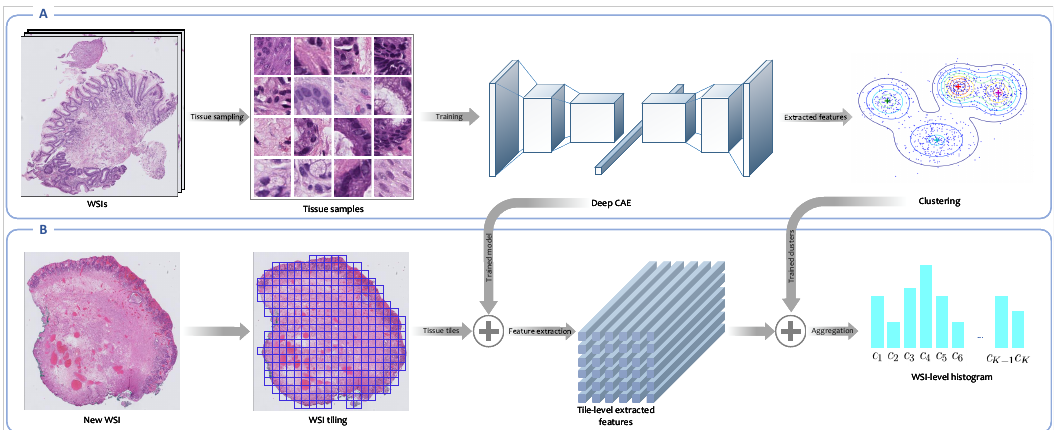
Figure 3. Overview of the unsupervised feature extraction framework. ( A ) This is the codebook learning phase. In this step, tissue tiles are sampled from WSIs in the training set. Neither the annotated areas nor the WSIs labels are used in this framework. An encoder is trained in an unsupervised fashion to map each high-resolution tissue tile into a low-dimensional embedding space, and then the Gaussian mixture model (GMM) is employed to cluster extracted features from tissue tiles into a number of clusters. Each cluster is indeed a morphological feature called a codeblock. The set of all codeblocks is called codebook. ( B ) This is the WSI encoding phase. In this phase, the trained convolutional autoencoder (CAE) is employed to extract embedding features from high-resolution tissue tiles derived from new WSIs. Then, the posterior probabilities of clusters constructed in the previous phase for patch-level extracted features are calculated. Finally, the posterior probabilities corresponding to all patches derived from a WSI are aggregated into a WSI-level probabilities histogram.